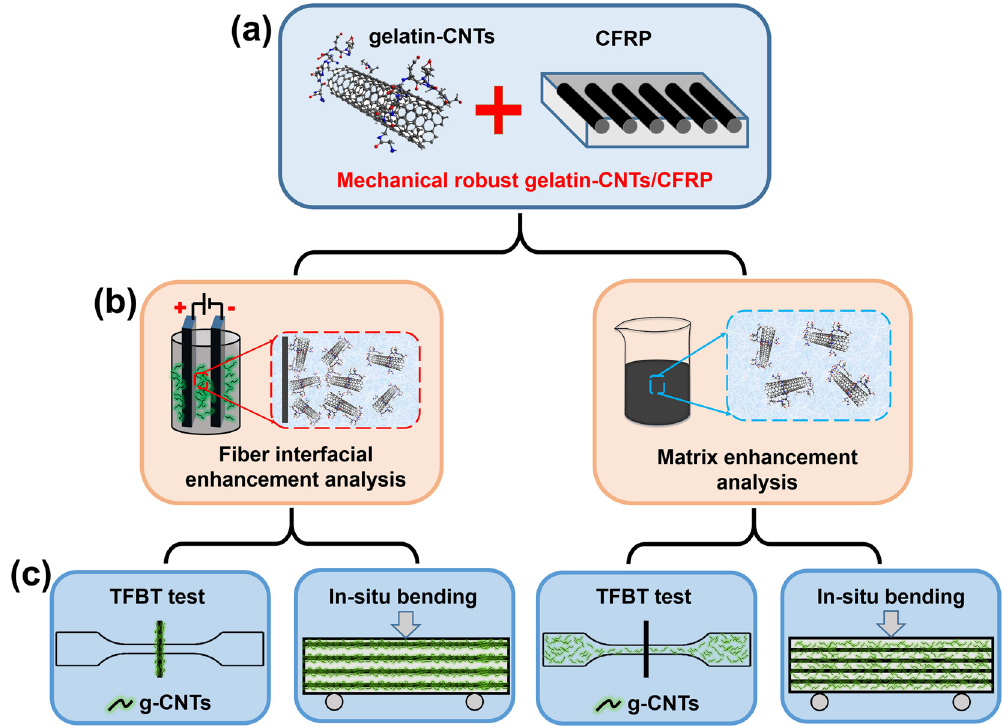
Figure 1: Mechanical robust gelatin - CNTs/CFRP composite ( a ) ; two routes for g - CNTs to enhance CFRP composite ( b ) ; experiments to test the strengthening e ff ect from fi ber interfacial enhancement and matrix enhancement ( c )